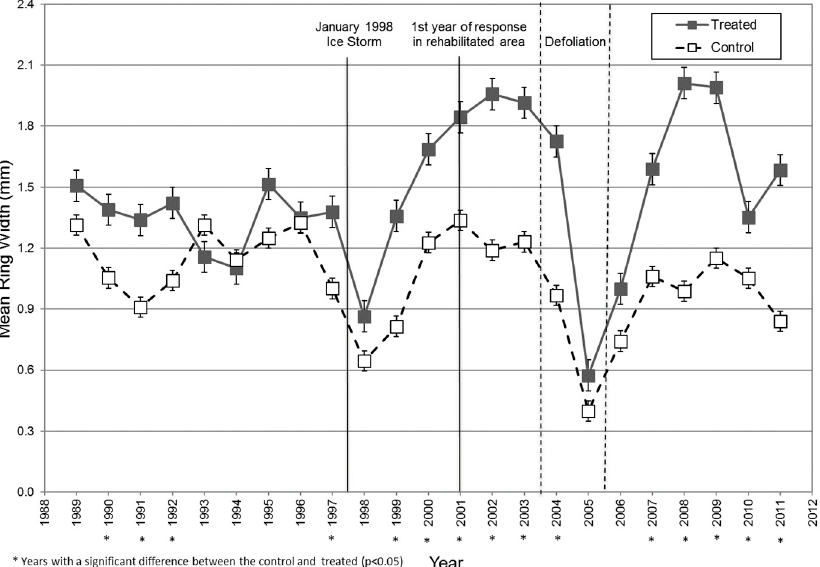
Figure 3. Taylor Creek annual pattern of ring width growth (mm) for 9 years prior to and 13 years after the January 1998 ice storm with standard error ( ± 0.1068), and the recovery pattern after a 2-year (2004–2005) defoliation by the forest tent caterpillar. Years with significant differences in the mean ring width between treatment groups are designated by asterisk ( p < 0.05).